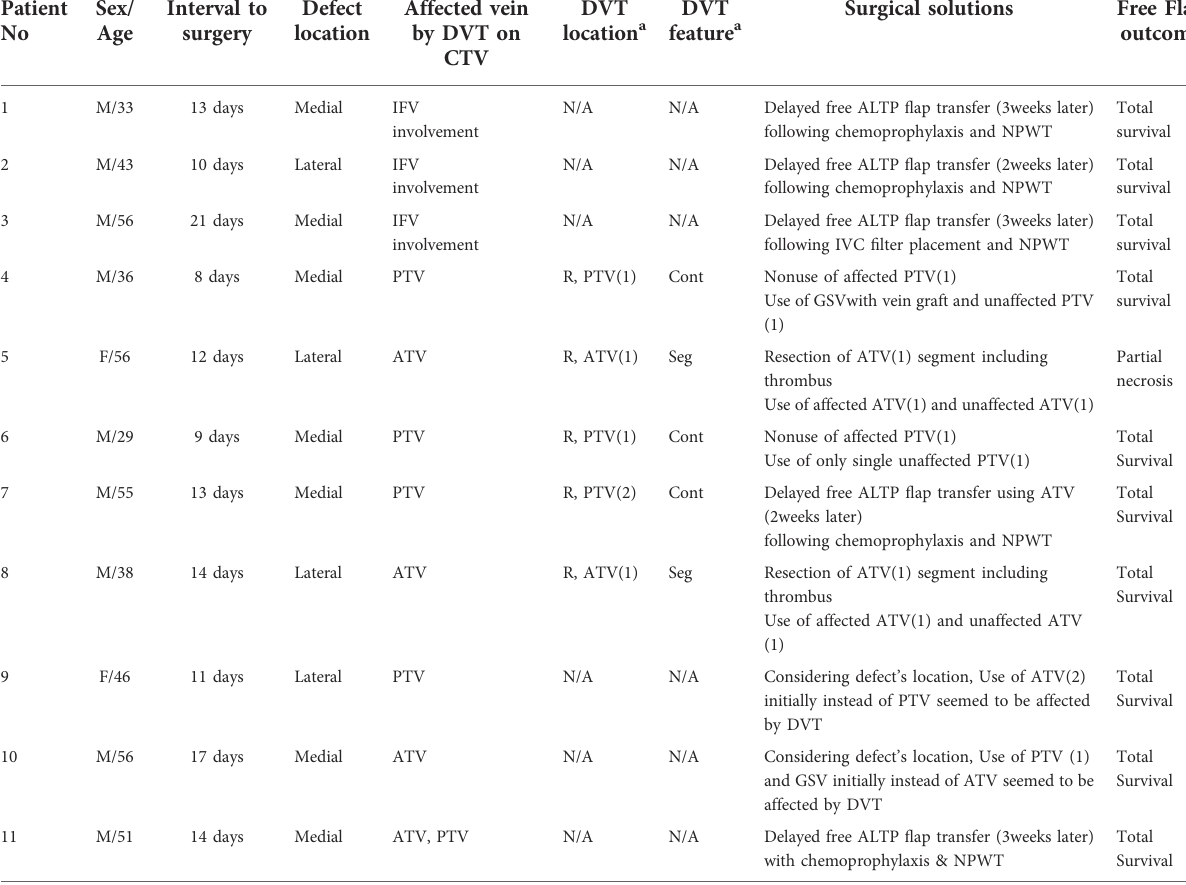
TABLE 1 Clinical features of the patients with DVT identi fi ed by preoperative CTV for a free ALTP fl ap transfer. Patient